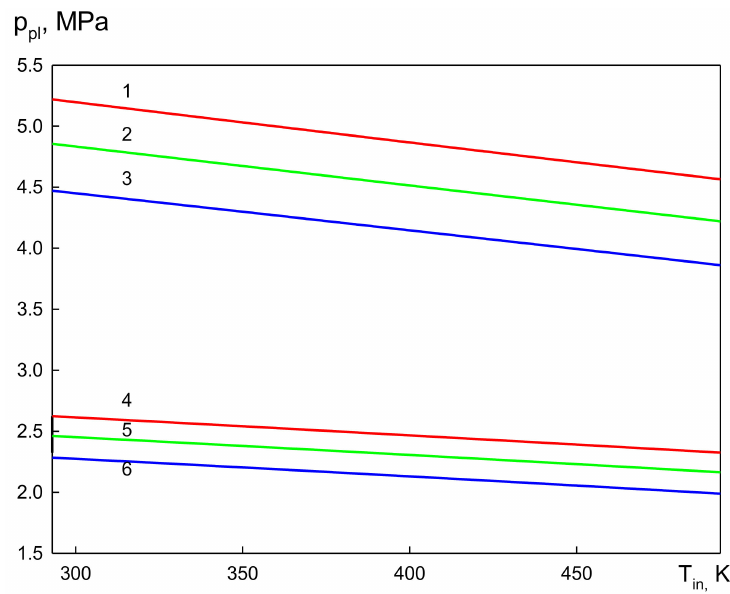
Figure 7. Dependence of the plastic resistance limit on the temperature of the inner wall: R in = 0.1 m, R ex = 0.105 m. Curves 1–3: Λ p = 100 nm, δ = 10 nm; curves 4–6: Λ p = 200 nm, δ = 20 nm; curves 1 and 4: temperature of the outer wall of the pipe T ex = 293 K; curves 2 and 5: T ex = 393 K; curves 3 and 6: T ex = 493